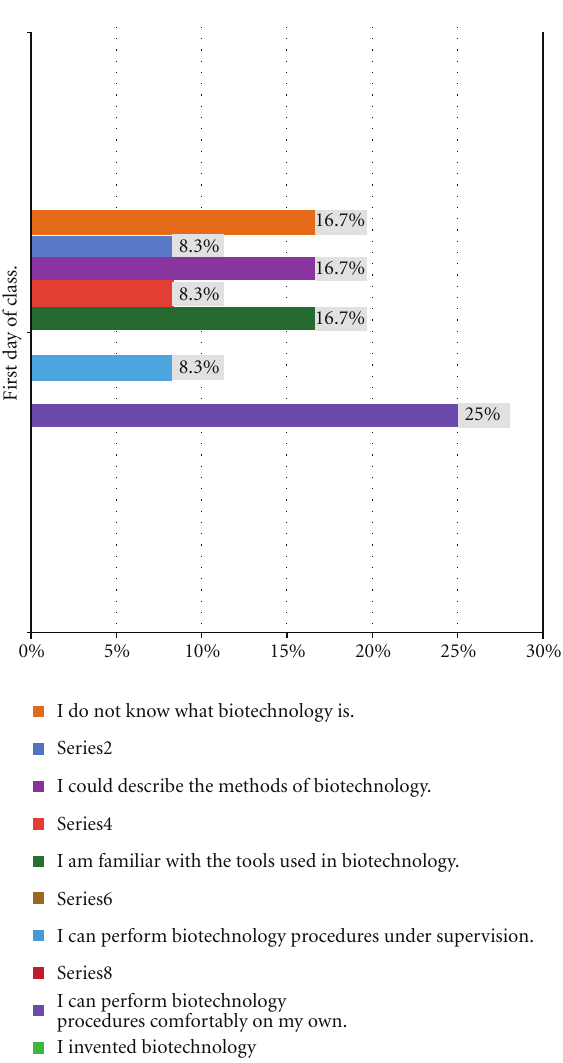
Figure 4: Survey Excerpt: Students’ perception of their own comfort with the biotechnology on the first day of the